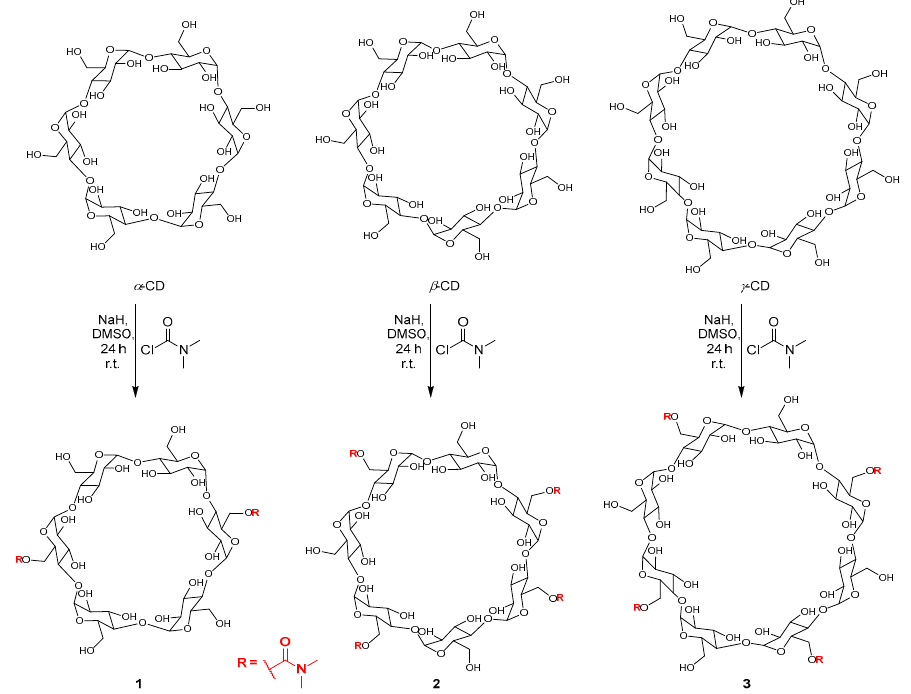
Scheme 1. Reaction scheme for the functionalization of CDs by dimethylcarbamoyl chloride. The positions of R groups are